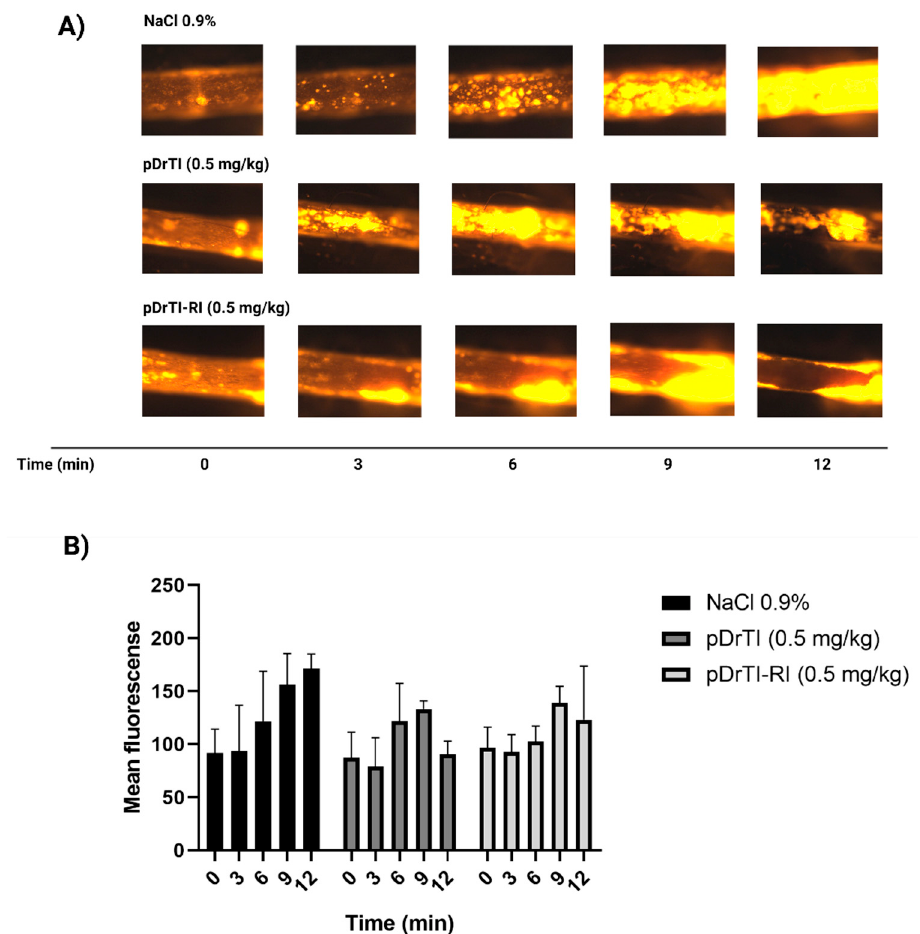
Figure 6. Platelet behavior after treatment with peptides—( A ) pDrTI (0.5 mg/kg) or pDrTI-RI (0.5 mg/kg) were administered by retro-orbital injection before dissection. Rhodamine 6G was administered by retro-orbital injection for mitochondrial platelet and leukocyte labeling. The arterial injury was induced by the application of filter paper saturated with 15% FeCl 3 . The injured artery was monitored for 12 min with an image capture every 3 min using an intravital fluorescence microscope. ( B ) Mean fluorescence was quantified using the software ImageJ version 1.46r. N = 3 animals.